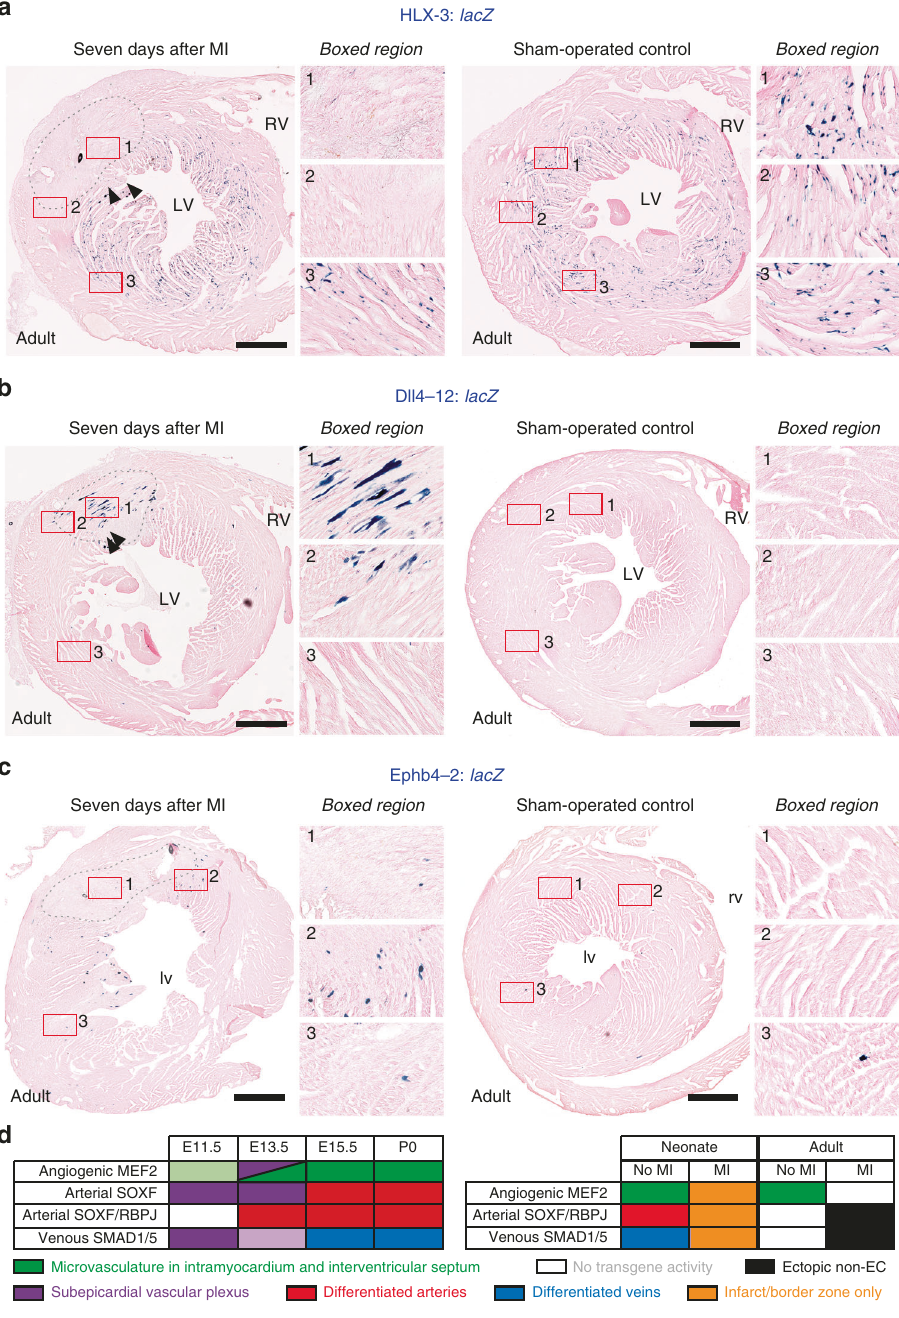
Fig. 10 The adult heart does not activate developmental vascular regulatory pathways after MI. a – c Permanent ligation of the left anterior descending coronary artery was performed on transgenic adult male mice to induce MI. Representative sections through HLX-3: lacZ ( a , n = 4 biologically independent animals), Dll4-12: lacZ ( b , n = 5 biologically independent animals), and Ephb4-2:lacZ ( c , n = 4 biologically independent animals) hearts collected 7 days after MI surgery compared to sham-operated controls. Additional time points after MI showed similar responses and can be seen in Supplementary Fig. 19, cumulative n values are n = 12 biologically independent animals for HLX-3: lacZ , n = 13 biologically independent animals for Dll4-12: lacZ and n = 12 biologically independent animals for Ephb4-2: lacZ . Infarct regions are indicated by grey dashed line, transgene expression is detected by X-gal staining (blue). Magni fi ed views are shown of regions within the injury (box 1), at the injury border zone (box 2) and remote from the injury (box 3), and can be compared to sham- operated day seven controls. lv, left ventricle; rv, right ventricle. Black scale bars represent 500 µ m. d Schematic summarising activity patterns of different vascular regulatory pathways in the coronary vasculature during development and after ischaemic